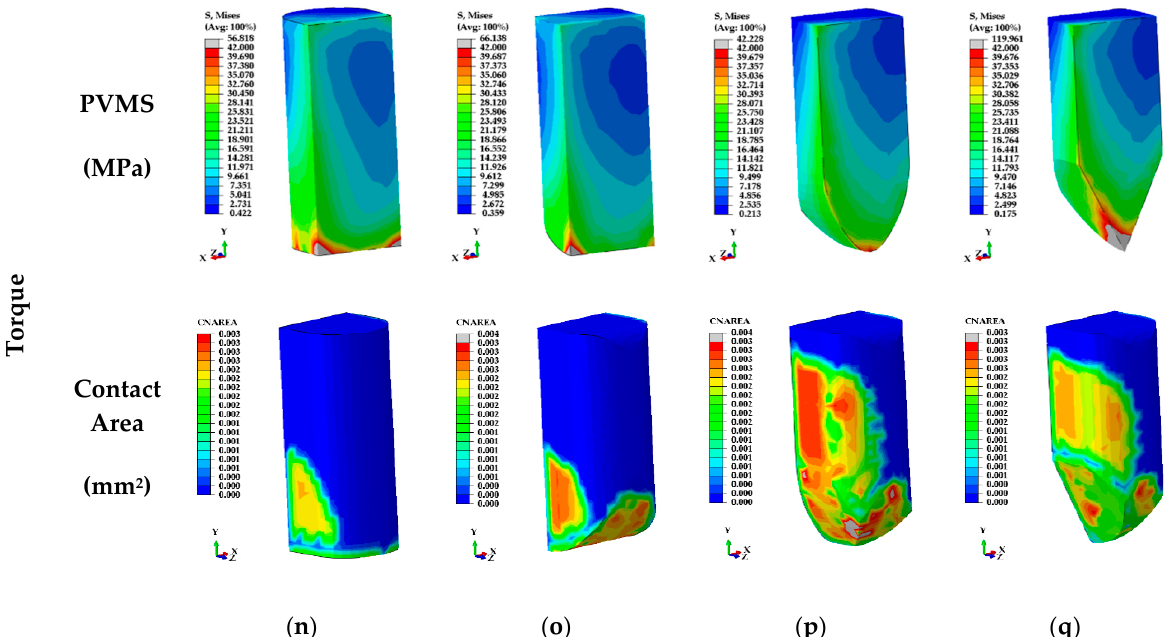
Figure 8. Results of stress distribution and contact area for attachments in each orthodontic treatment situation. ( a ) EX1; ( b ) EX2; ( c ) EX3; ( d ) EX4; and ( e ) EX5 for extrusion attachment; ( f ) IN1; ( g ) IN2; ( h ) IN3; ( i ) IN4; ( j ) IN5 for intrusion attachment; ( k ) RO1; ( l ) RO2; ( m ) RO3 for rotation attachment; ( n ) TO1; ( o ) TO2; ( p ) TO3; ( q ) TO4 for torque